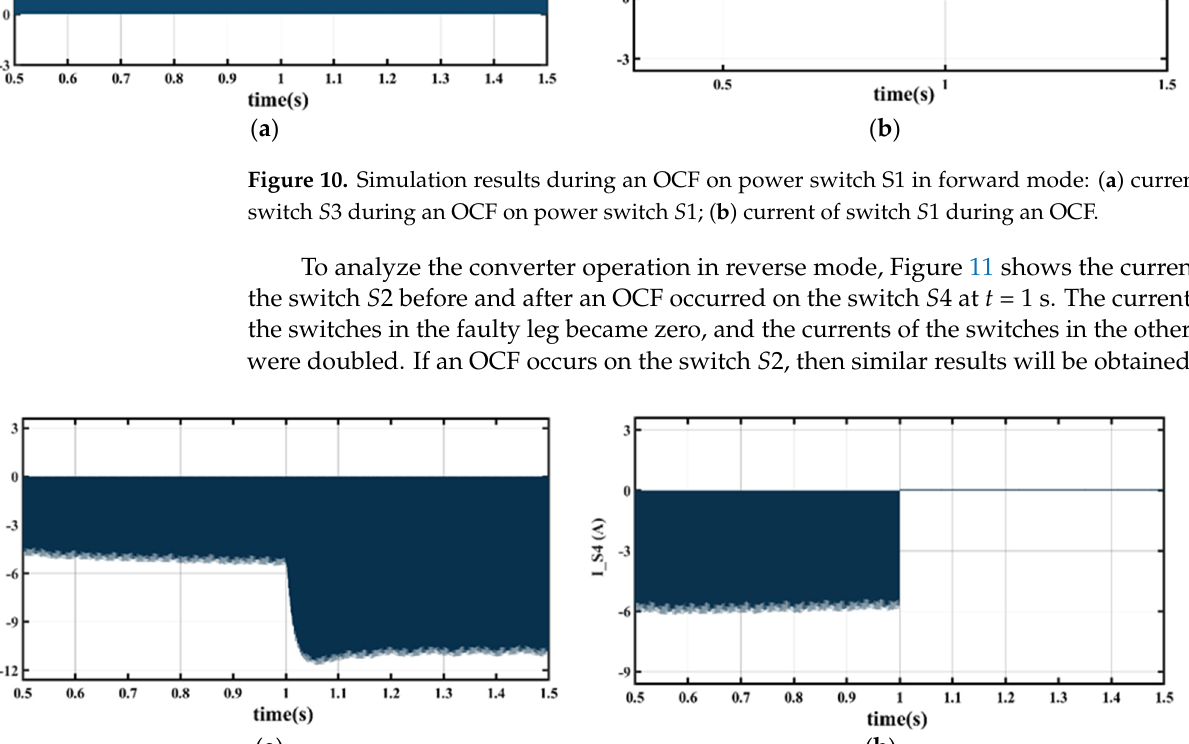
Figure 12. Simulation results for the proposed fault–tolerant topology with the proposed fault di- agnosis algorithm when an OCF occurs on the switch S1 in forward mode: ( a ) current of switch S3 ; ( b ) current of switch M1 .